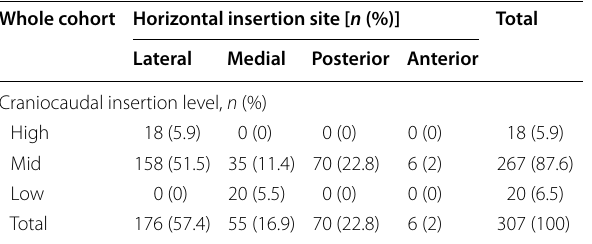
Table 2 The distribution of all CD insertion patterns in the